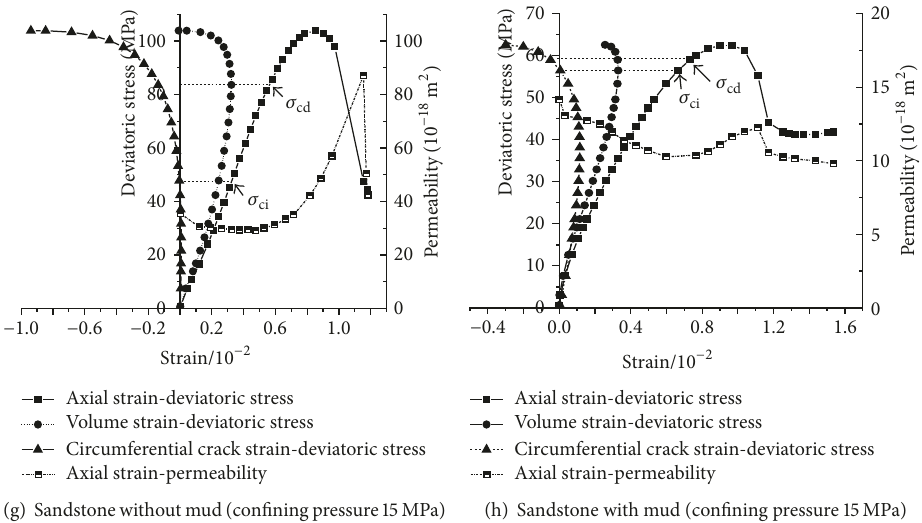
Figure 4: Gradual-cracking process and permeability behavior considering different confining pressure and water pressure valued 2MPa.